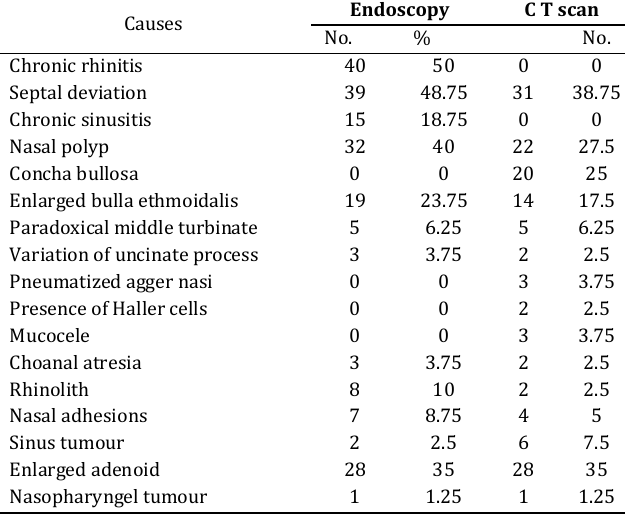
Table 5: Chronic nasal obstruction diagnosis by Endoscopy and